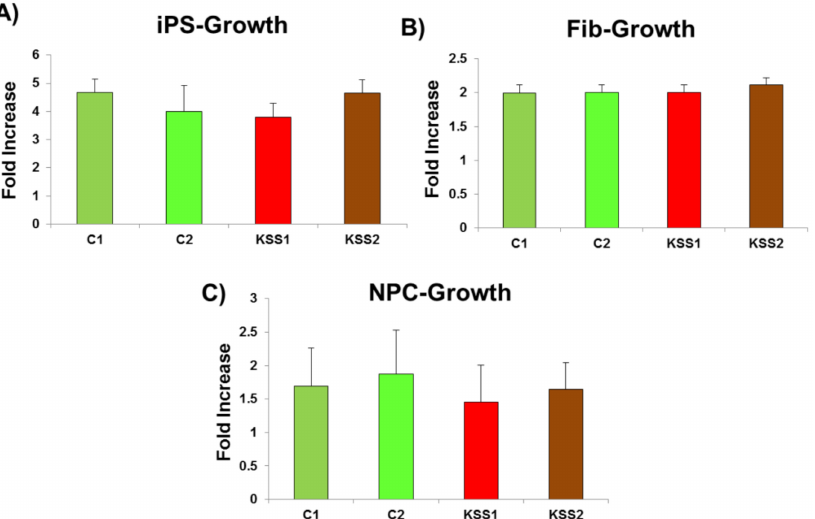
Figure 5. Cellular doubling analysis was carried out to assess the changes in growth potential of indiced pluripotent stem cells (iPSC) and differentiated cells from patients and healthy controls. ( A ) There was no difference in cell proliferation in iPSC of both the patients compared to iPSC from healthy individuals. ( B , C ) Additionally, there were no alterations in the rate of cell proliferation in iPSC derived ( B ) fibroblasts and ( C ) Neural progenitor cells (NPC) of both the patients in comparison to healthy cells. n = 3, each experiment was repeated 3–4 times.